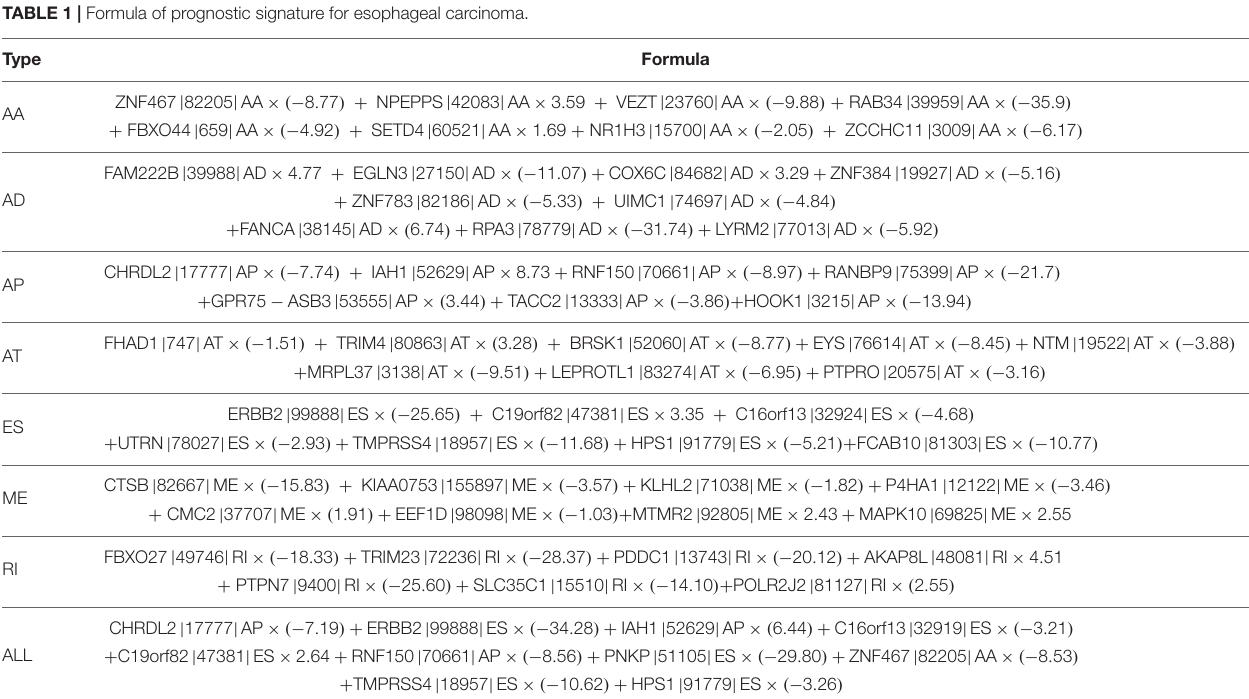
FIGURE 4 | Gene interaction network and functional analysis of OS-associated alternative splicing events in ESCA. (A) biological processes (BP). (B) cellular component (CC). (C) molecular function (MF). (D) KEGG pathway analysis. (E) Gene interaction network of corresponding parent genes of OS-associated AS events generated by Cytoscape. TABLE 1 | Formula of prognostic signature for esophageal